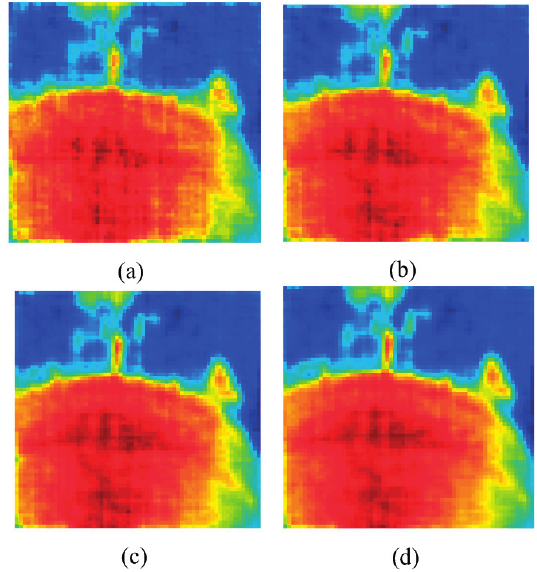
Figure 6. ( a ) Reconstruction image of Figure 5a by RRIA using 40% undersampling; ( b ) Reconstruction image of Figure 5a by RRIA using 50% undersampling; ( c ) Reconstruction image of Figure 5a by RRIA using 60% undersampling; ( d ) Reconstruction image of Figure 5a by RRIA using 70%